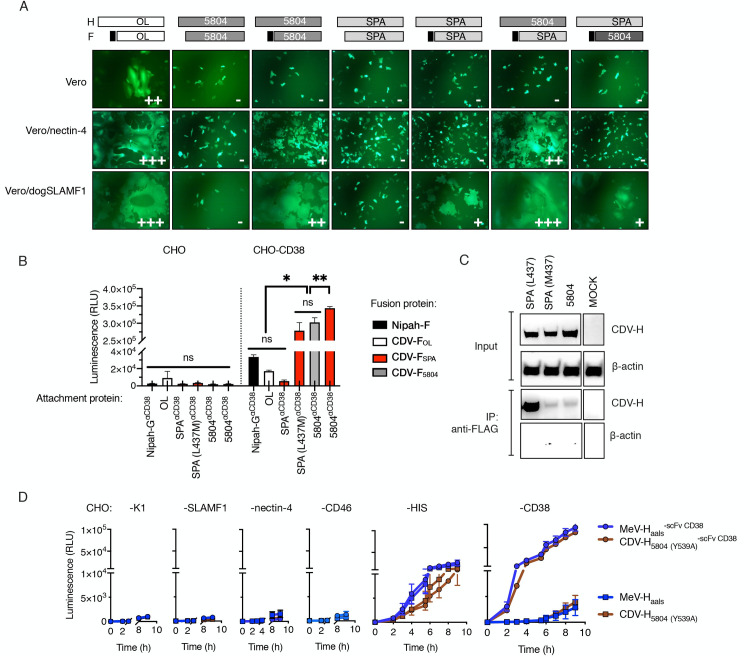
Heterologous combination of wild-type CDV H/F with a shortened signal peptide results in enhanced receptor-dependent fusion due to a weaker H-F interaction.(A) Syncytia formation in cells cotransfected with CDV-F, CDV-H and eGFP. The signal peptides of CDV-F were replaced with the homolog from MeV-F, as indicated by the black boxes in the schematic. Twenty-four hours after cotransfection, fusion score was assessed under the GFP channel. (B) Quantitative fusion assay. Effector BHK cells were transfected with the indicated combination of attachment (CDV-H or Nipah-G) and fusion (F) proteins plus one of the dual-split reporter plasmids. Target CHO cells and CHO cells expressing CD38 (CHO-CD38) were transfected with the other dual-split reporter plasmids. 16 hours post-transfection cells were overlaid and Renilla luciferase activity was determined (RLU) 8 hours later. Values represent the mean ± standard deviation (SD) of one representative experiment performed in triplicate. Statistical significance was determined using one-way ANOVA with Holm-Sidak’s multiple comparison test (ns, not significant *, p<0.05; **, p<0.002; ***, p<0.0001). (C) CDV-H/F coimmunoprecipitation. HEK293T cells transiently expressing either wt or mutant HIS-tagged CDV-H proteins together with FLAG-tagged CDV-F proteins were lysed and immunoprecipitated (IP) with an anti-FLAG antibody. The signal intensity was determined using an anti-HIS antibody. (D) Quantitative fusion assay of fully retargeted CDV-H and MeV-H proteins onto CHO cells and CHO cells derivates. Either HIS-tagged or HIS-tagged and CD38-retargeted MeV-H/F and CDV-H/F complexes were transfected into effector cells and luminescence signal was determined over time. MeV-Haals = MeV-H blinded for CD46, nectin-4 and SLAMF1 via amino acid substitutions Y481A, R533A, S548L and F549S.